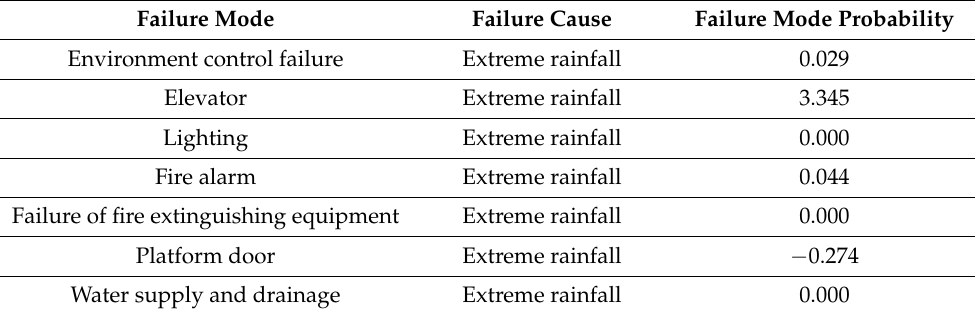
Table 6. Failure mode probability of electromechanical system of each line—examples.